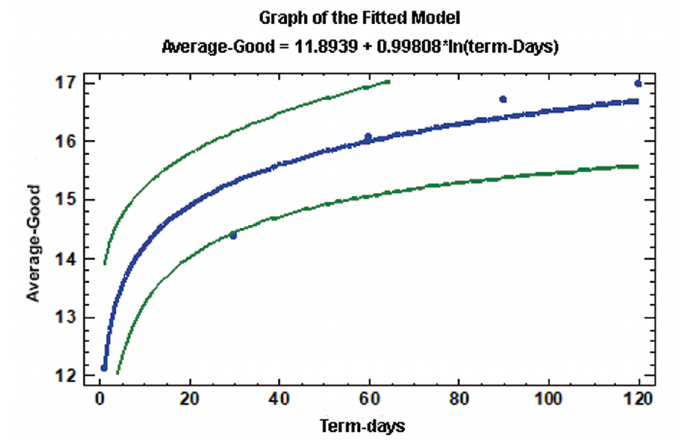
Figure 2. Adjusted Model. Font Statgrafics Centurion XVI Centurion